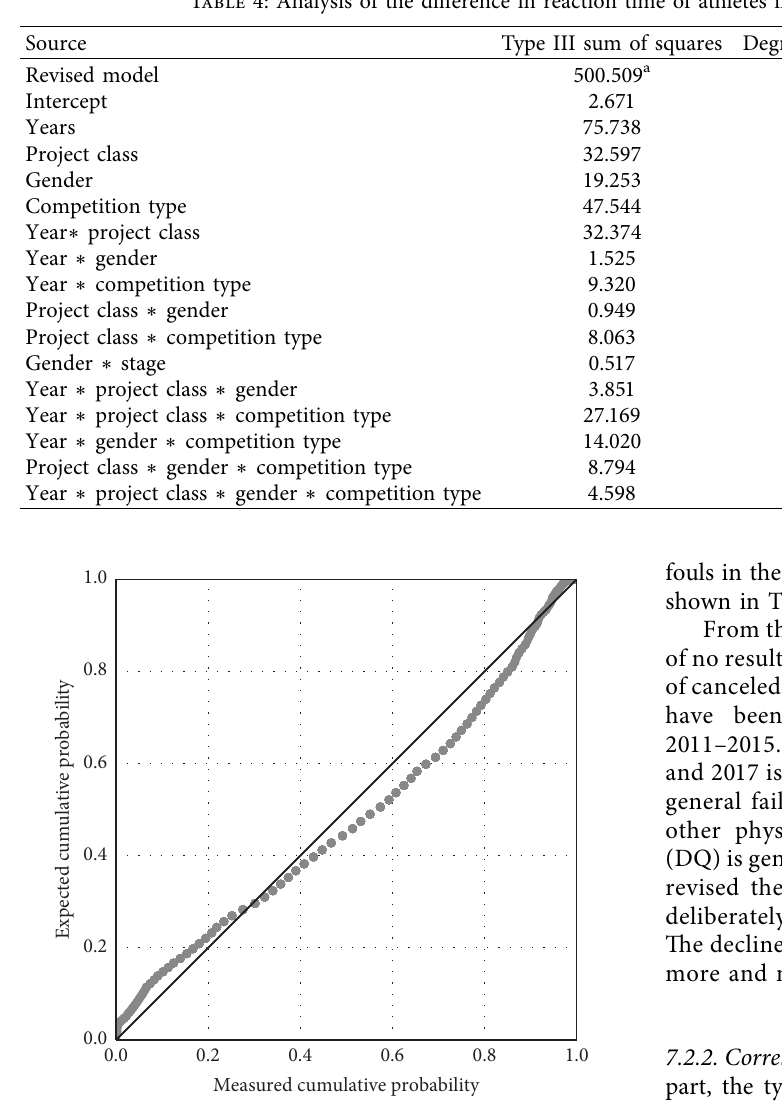
Figure 1: Normal P − P diagram during reaction